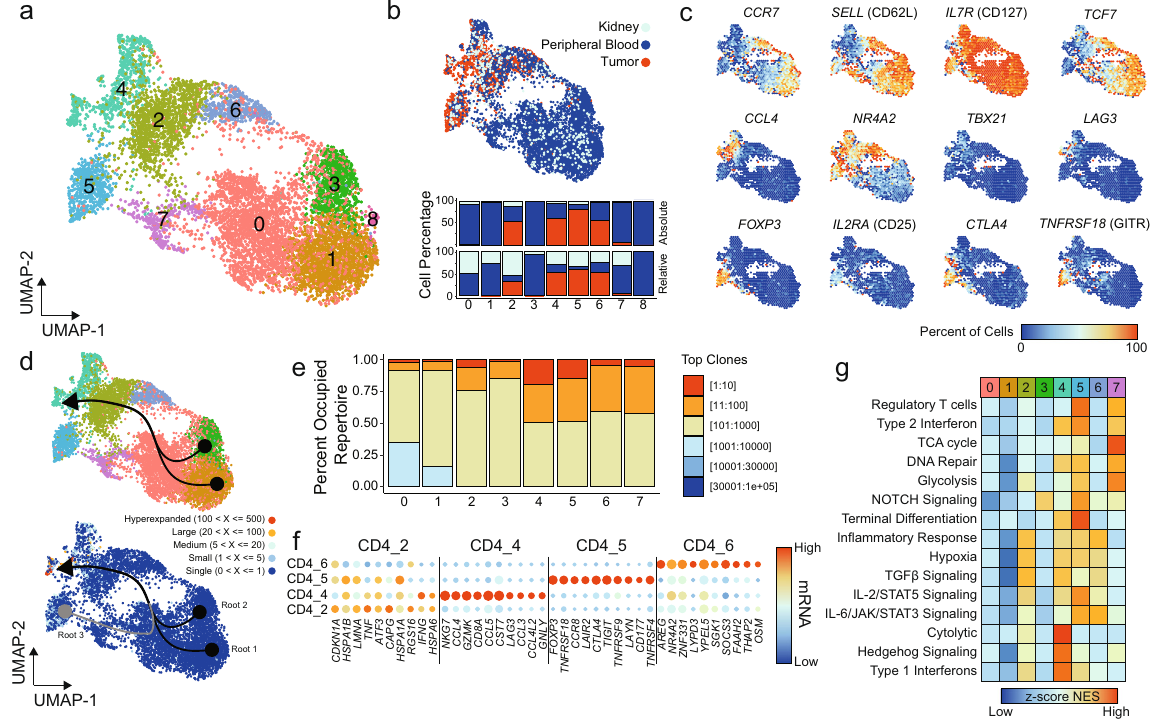
Fig. 4 Single-cell CD4 + T-cell characterization within ccRCC. a UMAP subclustering of CD4 + T cells (original clusters 4, 6, 10, 13, 15, and 20). b UMAP distribution of single cells by tissue type with relative and absolute percent of cells by tissue in each cluster. c Percent of cells expressing selected markers for T-cell biology. d CD4 + UMAP of subclusters (upper panel) and clonotype frequency (lower panel) overlaid with slingshot-based 36 cell trajectory starting from CD4_1 (root 1) and CD4_3 (root 2) with relative pseudotime for all curves calculated using slingshot. e Occupied repertoire space for CD4 + subclusters. f Top ten markers for TI-predominant CD4 + subclusters. Size of points are relative to percent of cells in the subcluster expressing the indicated mRNA species. g Z-transformed normalized enrichment scores from ssGSEA for selected gene sets by subcluster. COMMUNICATIONS BIOLOGY| (2021) 4:122